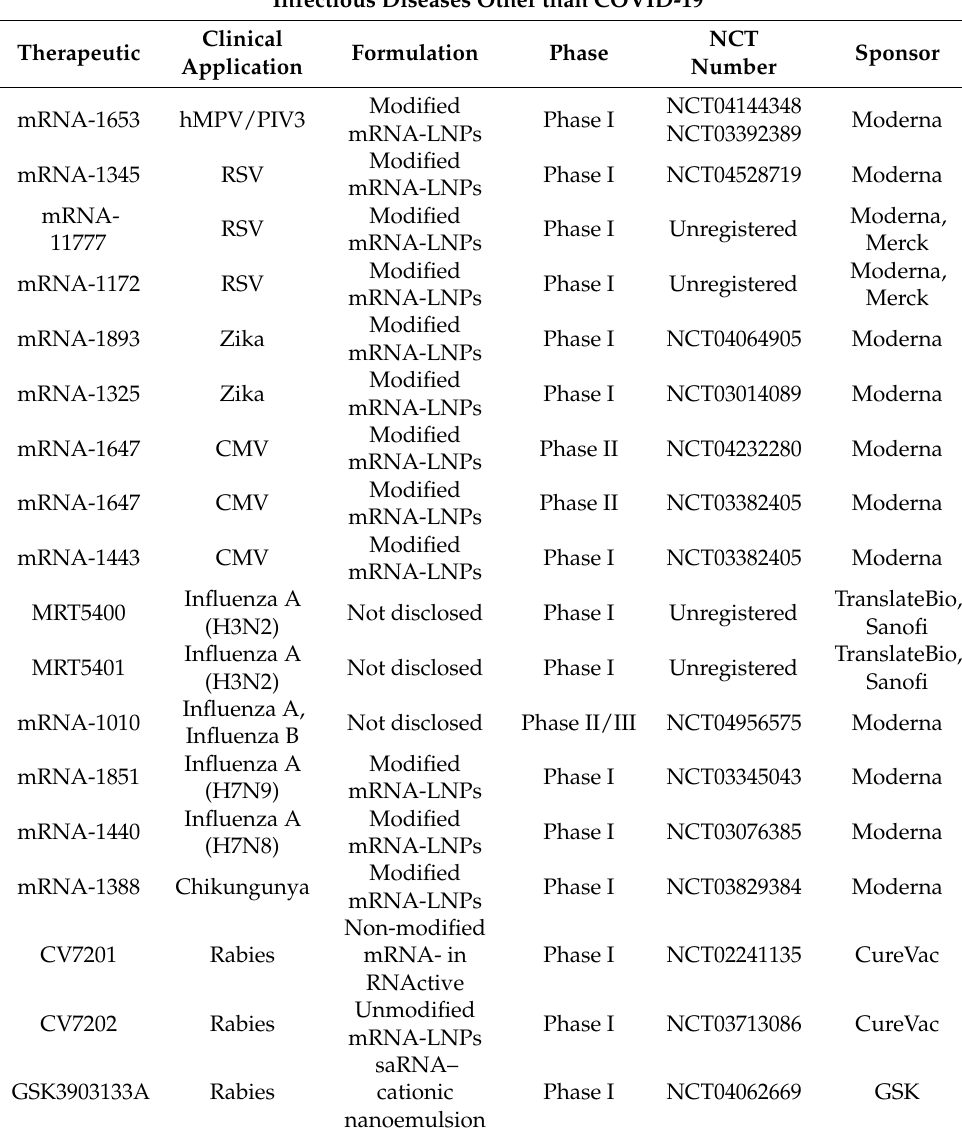
Table 1. mRNA Nanomedicines for Infectious Diseases in Clinical Trials. A list of clinical trials for infectious diseases other than COVID-19 is provided in this